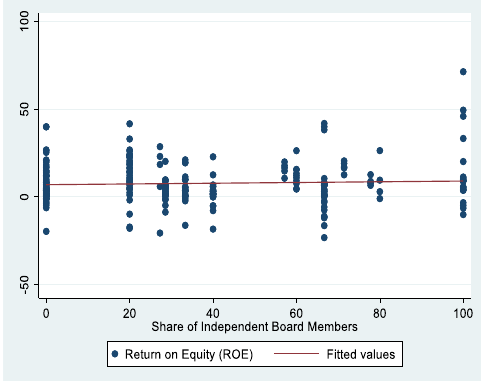
Figure 1. ROE and share of independent members.